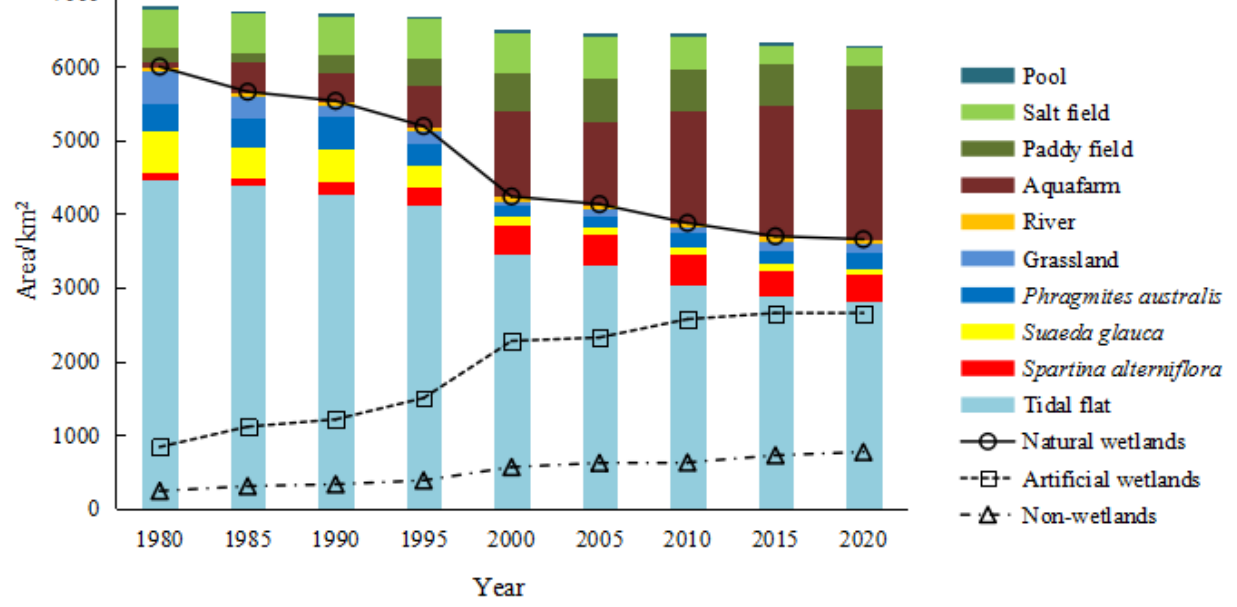
Figure 4. Changes in the area of different wetland landscapes in North Jiangsu during 1980–2020. Table 2. The area change statistics of the coastal wetland in northern Jiangsu during 1980–2020.